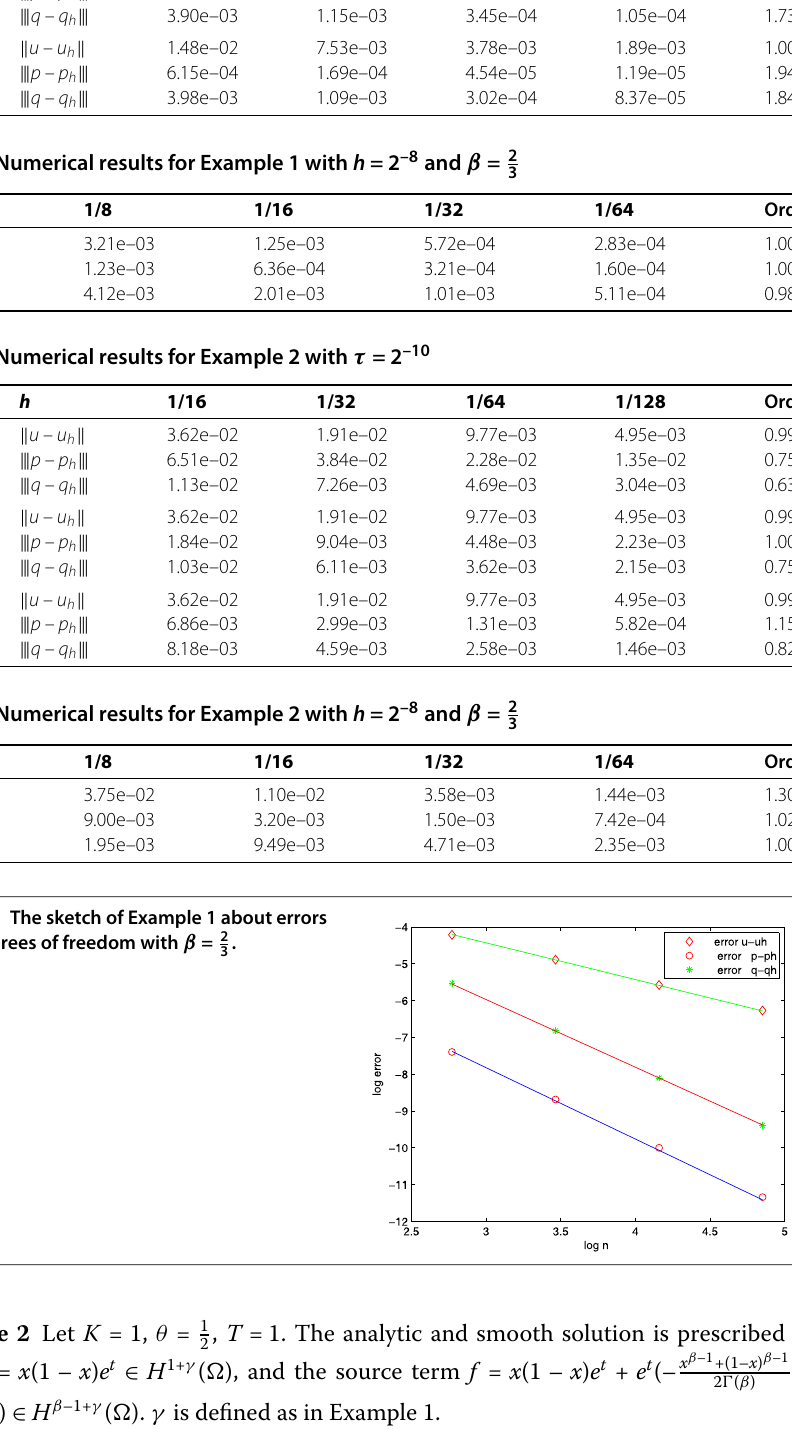
Example 2 Let K = 1, θ = 1 , T = 1. The analytic and smooth solution is prescribed 2